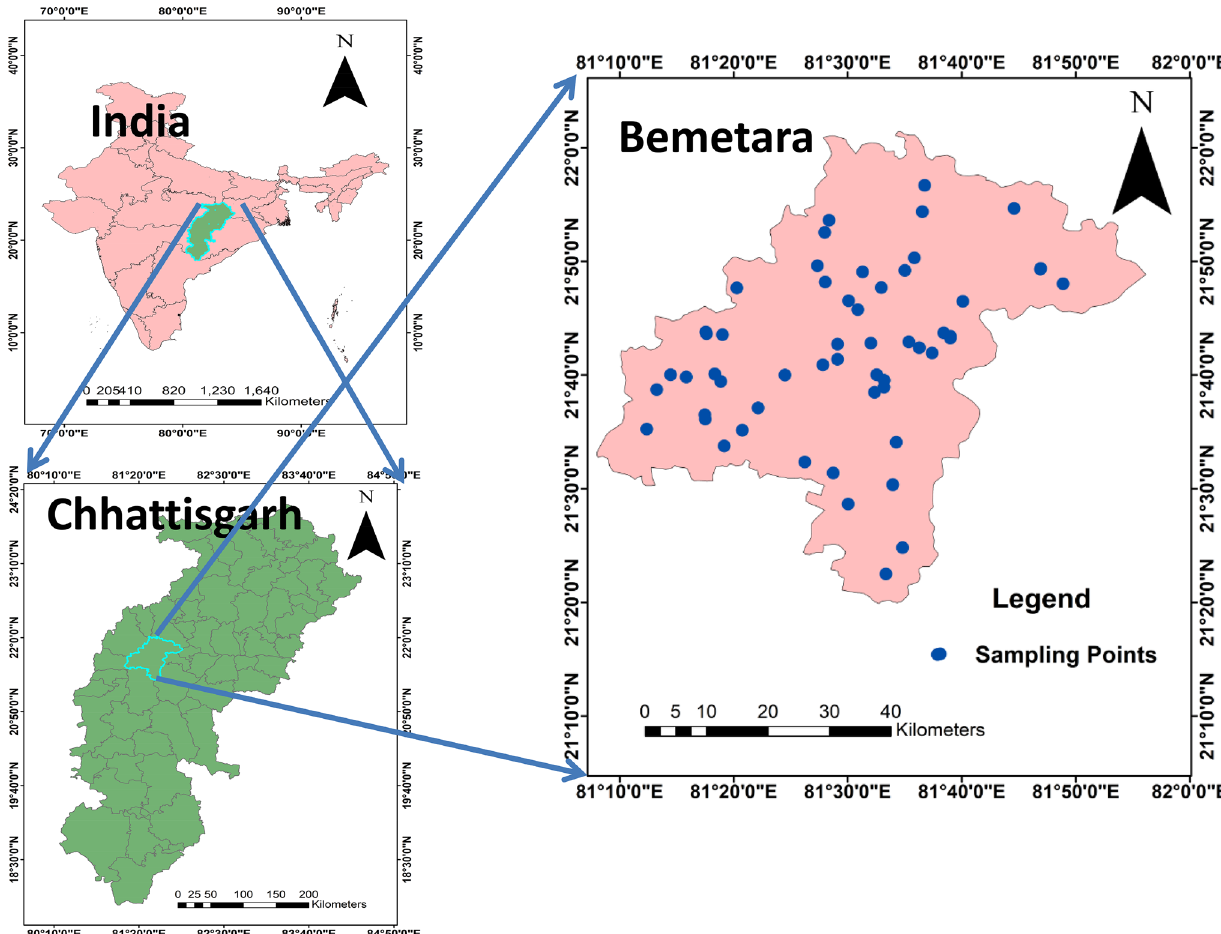
Fig. 1 Map showing the location of sampling sites in the study